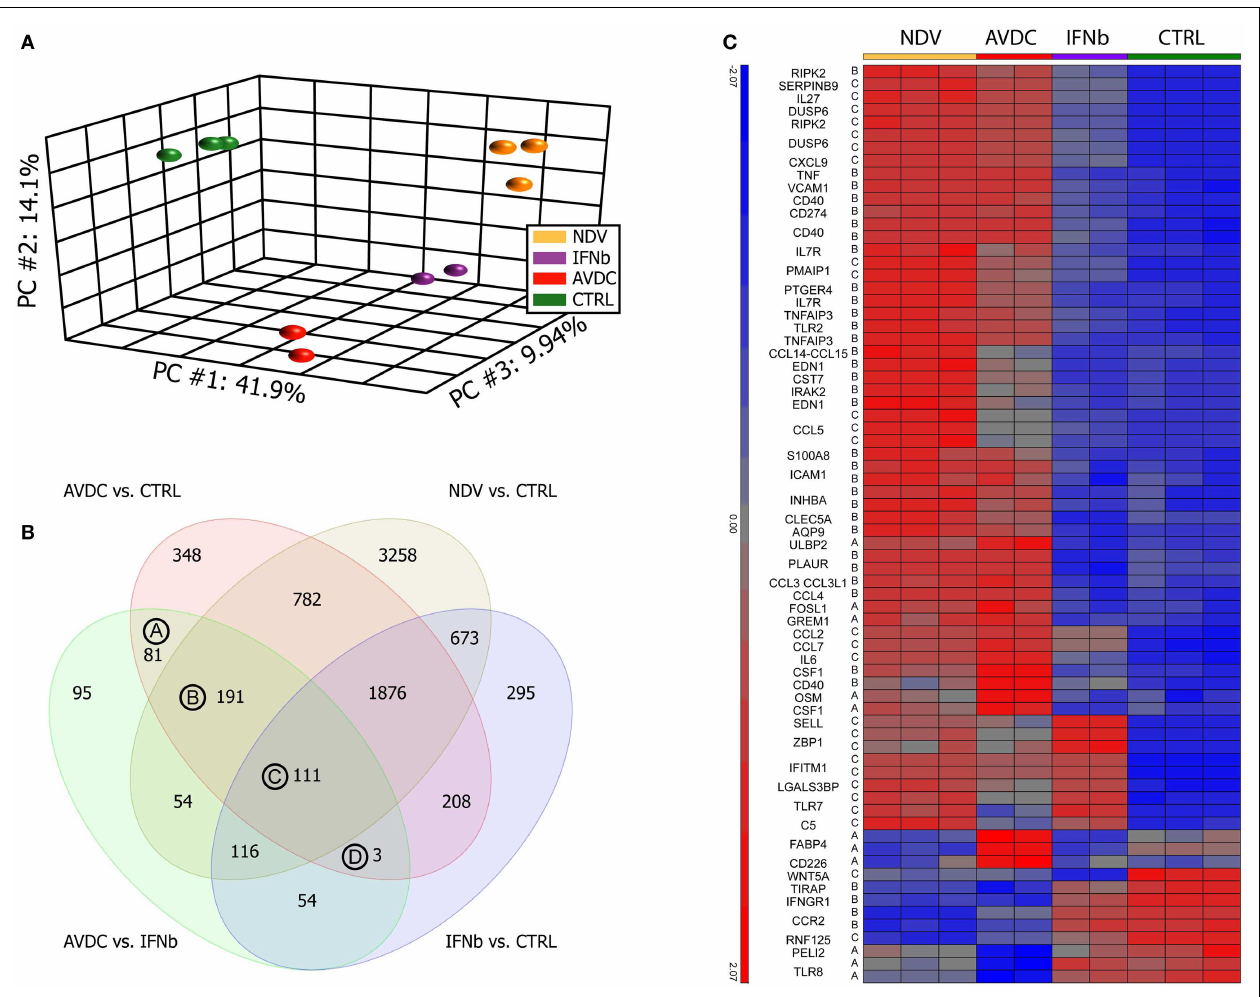
FIGURE 1 | Paracrine signaling from virus-infected DCs cells induce a different gene expression pattern compared to cells exposed to IFN β alone . Microarray profiles were obtained from human monocyte-derived DCs exposed to paracrine signaling from NDV infected DCs or to IFN β alone. Sample groups: NDV: DCs infected with NDV; IFN β : DCs exposed to IFN β alone; AVDCs: DCs exposed to paracrine signaling from NDV infected cells in a trans-well system; CTRL: naive unexposed and uninfected DCs.